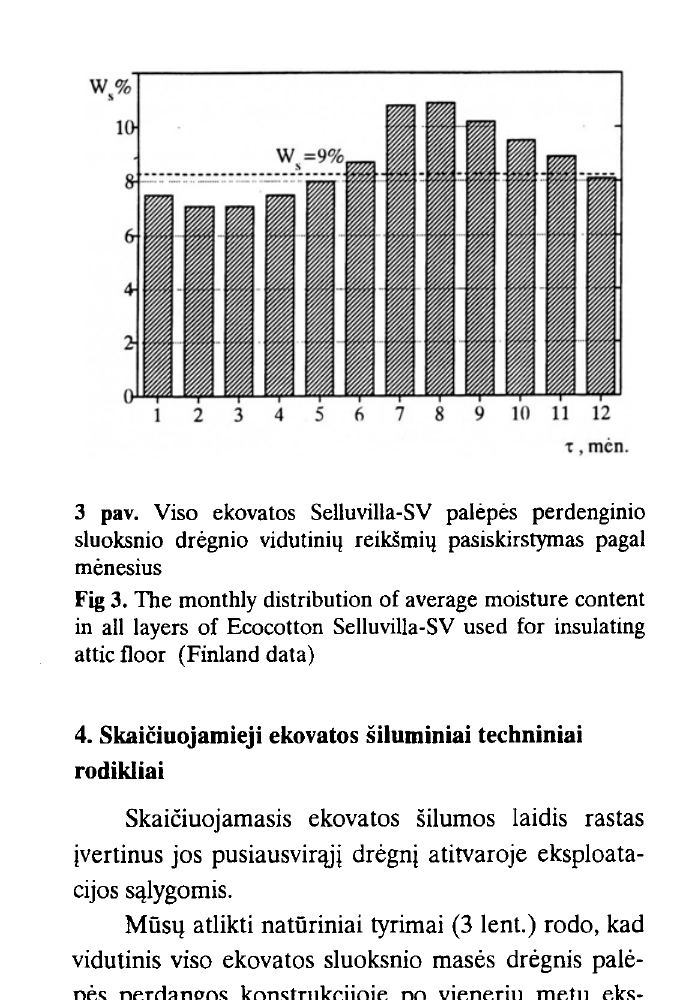
Table 3. 1be layer distribution of moisture content in Ecocotton used for insulating attic floor Objekto aprasymas ir bandiniq Ekovatos Sluoksnis, kuriame Ekovatos mases paemimo vi eta* uzpylimo laikas nustatytas dregnis dregnis